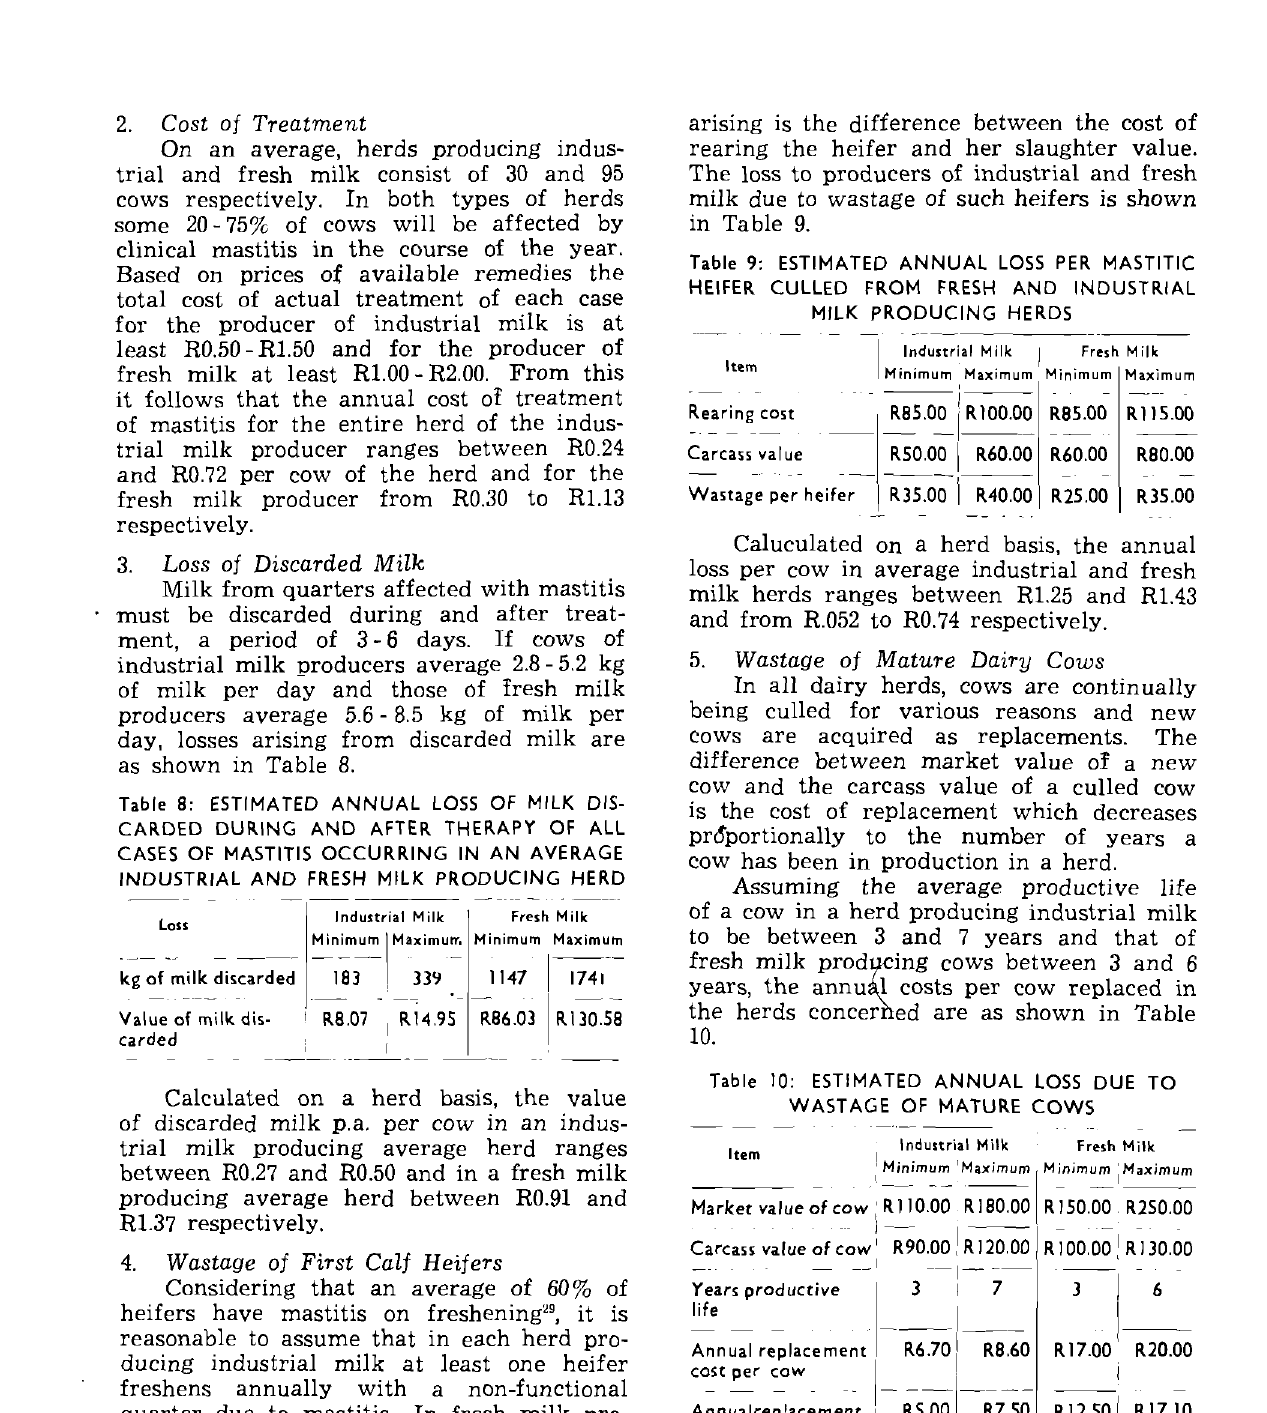
Table 9: ESTIMATED ANNUAL lOSS PER MASTITIC